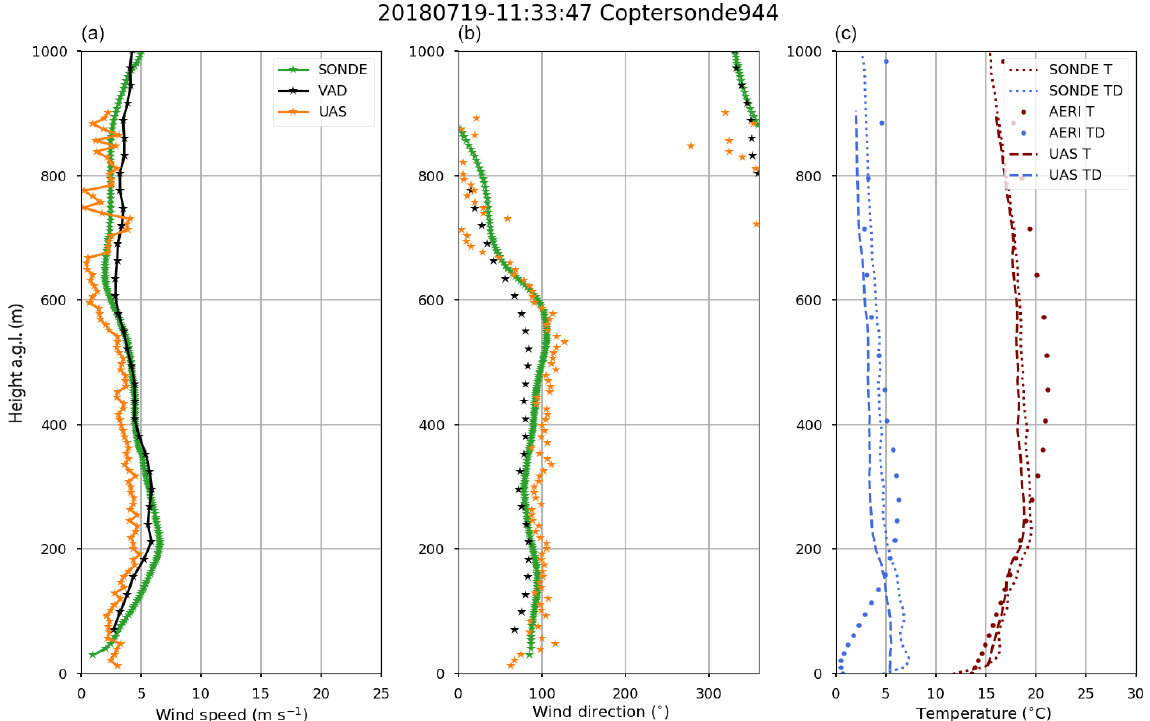
Figure 12. Profile plots of wind speed (a) , wind direction (b) , and temperature and dew point temperature (c) from CLAMPS, the Copter- Sonde, and a radiosonde on 19 July 2018 at 11:33UTC. The CopterSonde was launched just after the radiosonde, as soon as it was deemed the radiosonde was not in the flight path of the